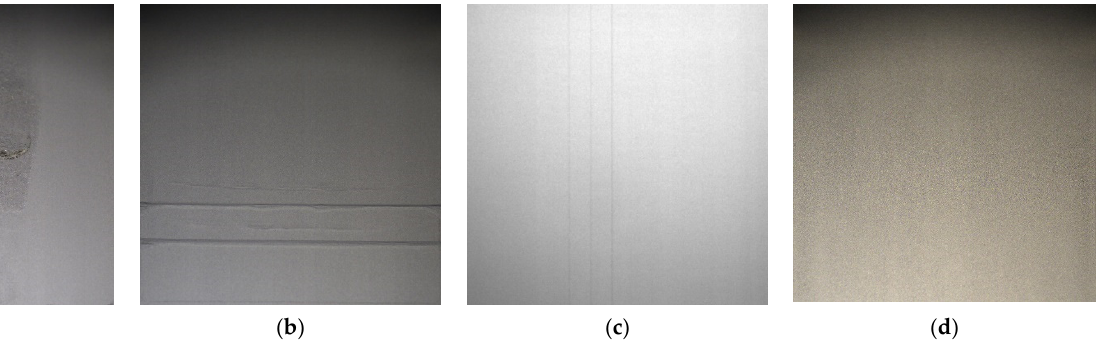
Figure 2. Three kinds of defects: ( a ) powder uncovered, ( b ) powder uneven, ( c ) recoater scratch and ( d ) flawless image. The flawless image is a normal case in the powder-spreading process.